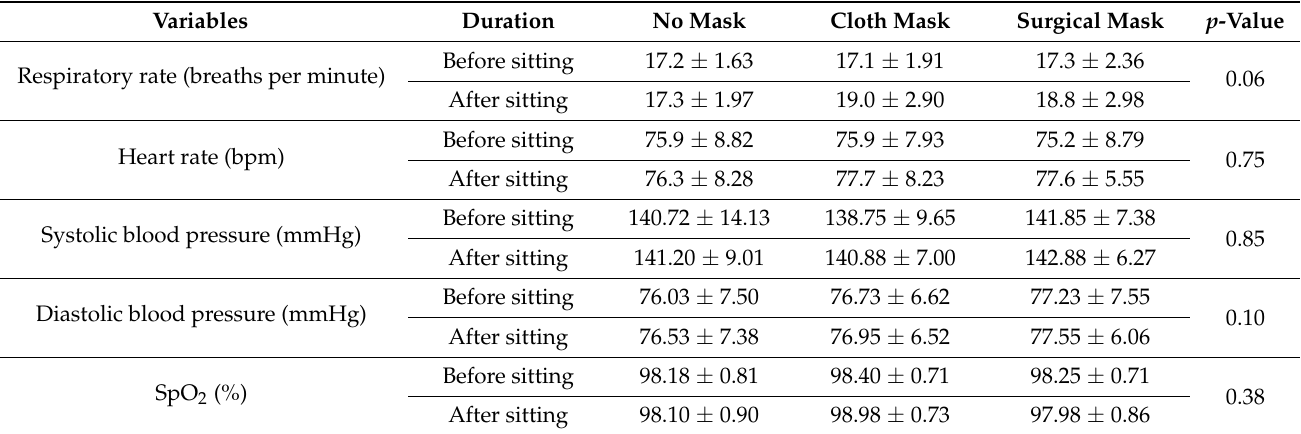
Table 2. Effects of face masks on cardiorespiratory parameters at